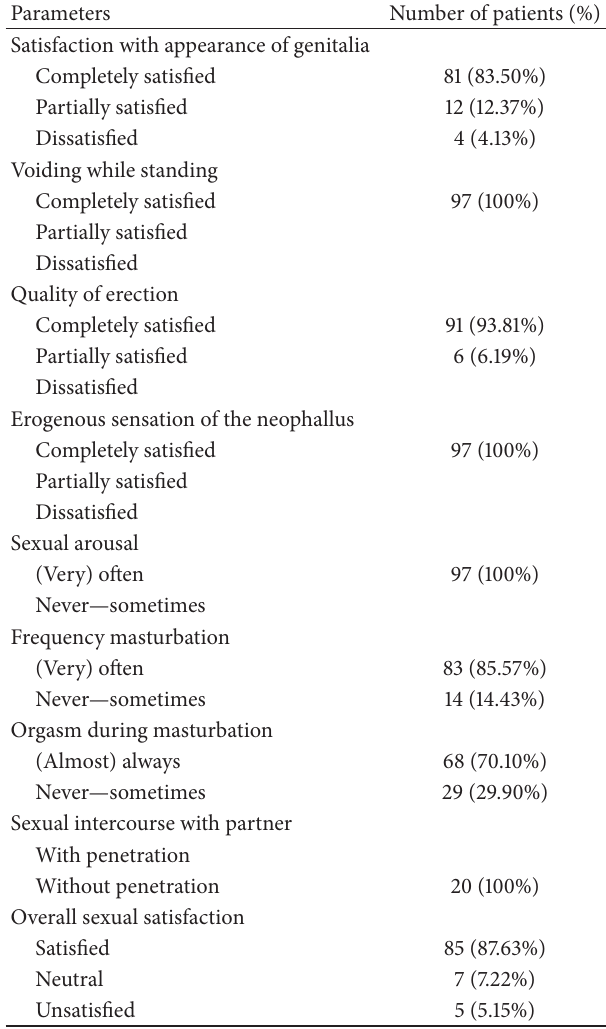
Table 1: Patients’ satisfaction with metoidioplasty